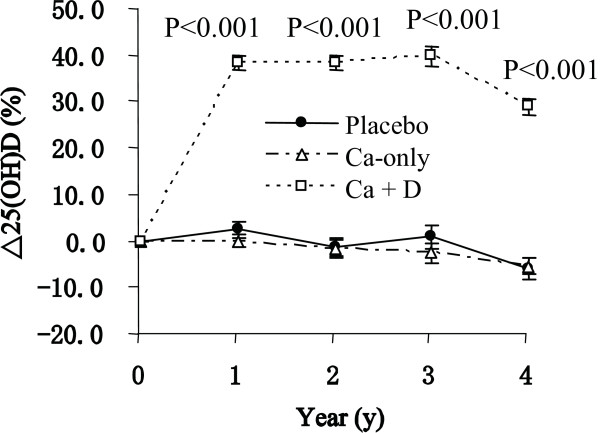
Percentage changes (Mean ± SE) in serum 25(OH)D by group assignment over the 4 years. The sample and the data analysis method are the same as Figure 1.